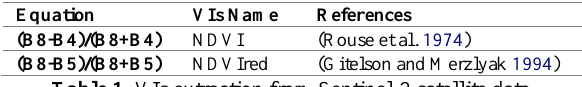
Table 1. VIs extraction from Sentinel-2 satellite